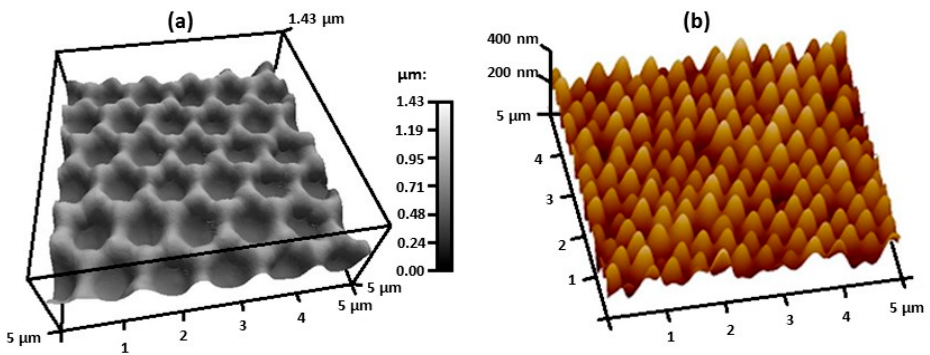
Figure 9. AFM images obtained for flexible SERS substrates obtained by ( a ) method that combines soft lithography with nanosphere lithography, 2013 [98] and ( b ) R2R UV-NIL, 2017 [99]. Reproduced with permission from Nature Publishing Group.